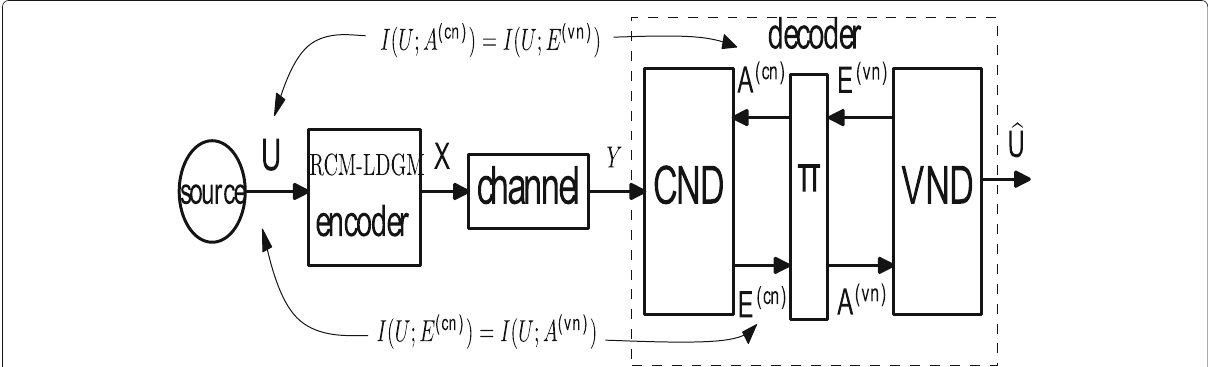
Fig. 2 Model for EXIT chart analysis. Random variable E ( vn ) models the extrinsic information produced at the VND when A ( vn ) is the a priori information arriving at the VND. Similarly, E ( cn ) is the extrinsic information produced at the CND when the channel output and A ( cn ) are the a priori information arriving at the CND. The block (cid:2) denotes the random connections of CN and VNs. The factor graph of the VND and CND is given in Fig.